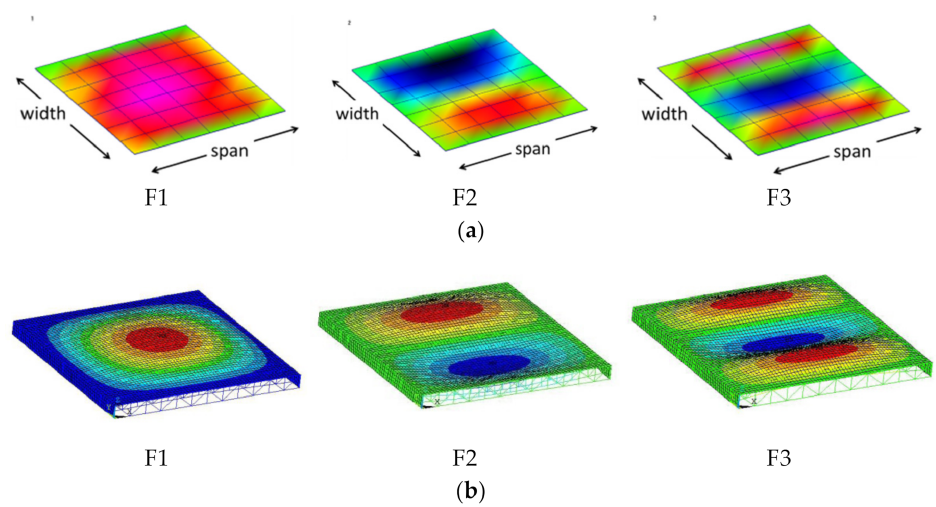
Figure 11. First three mode shapes obtained from the experiment ( a ) and the models ( b